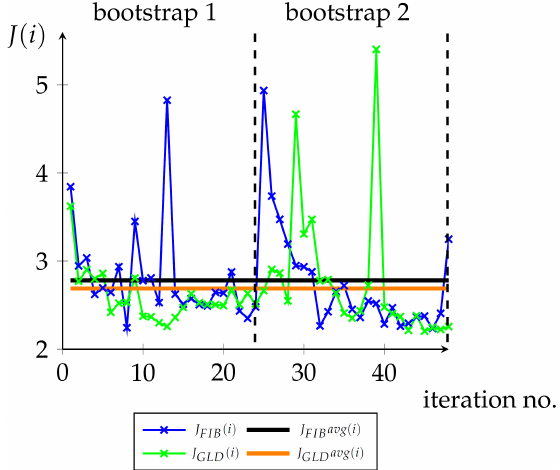
Figure 11. The altitude controller gains and J = f ( k P , k D ) values during auto-tuning process using GLD (white color) and FIB (green) methods; k Dinit = 10 (marked in red).